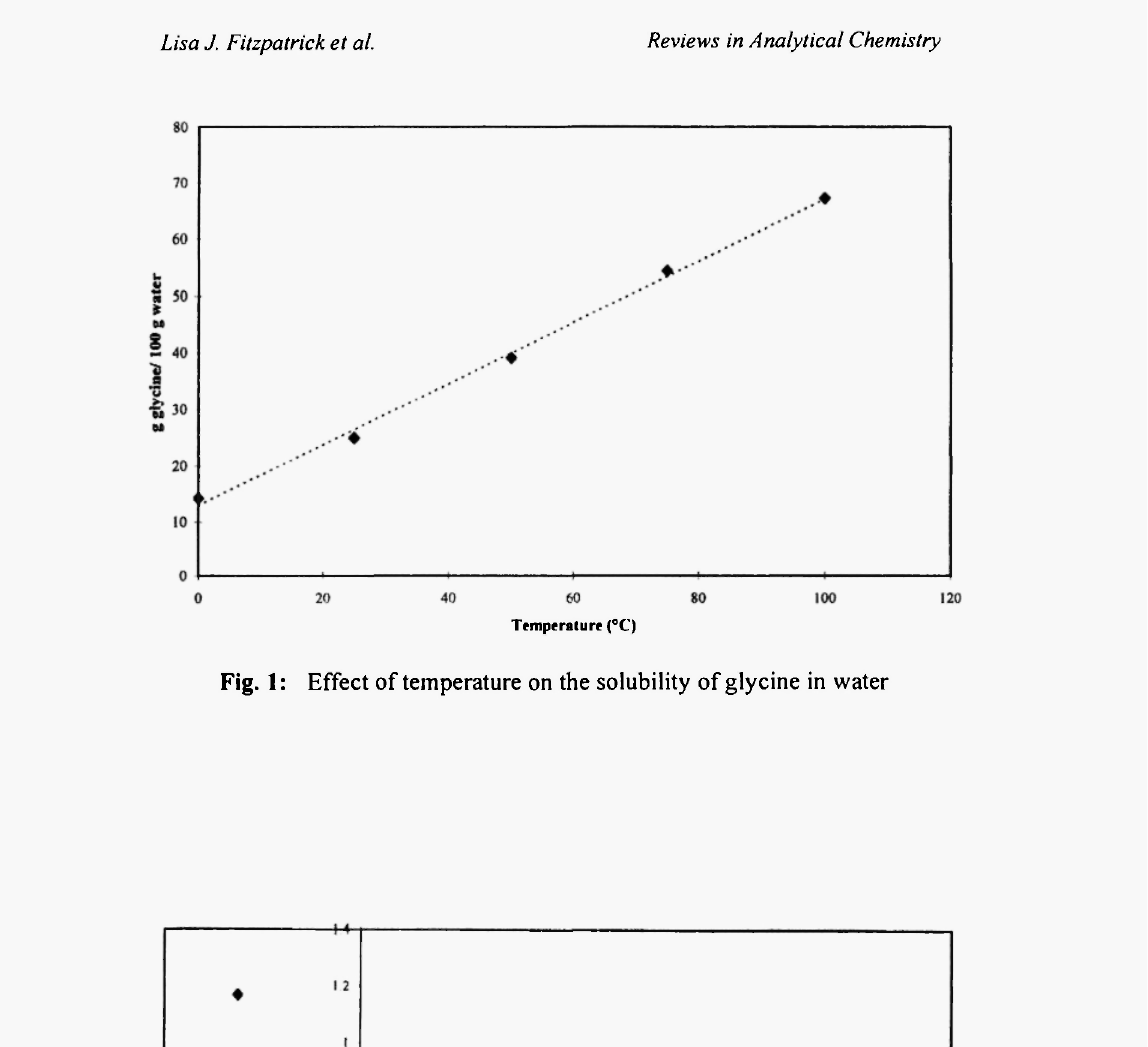
Fig. 2: Effect of temperature on the viscosity of